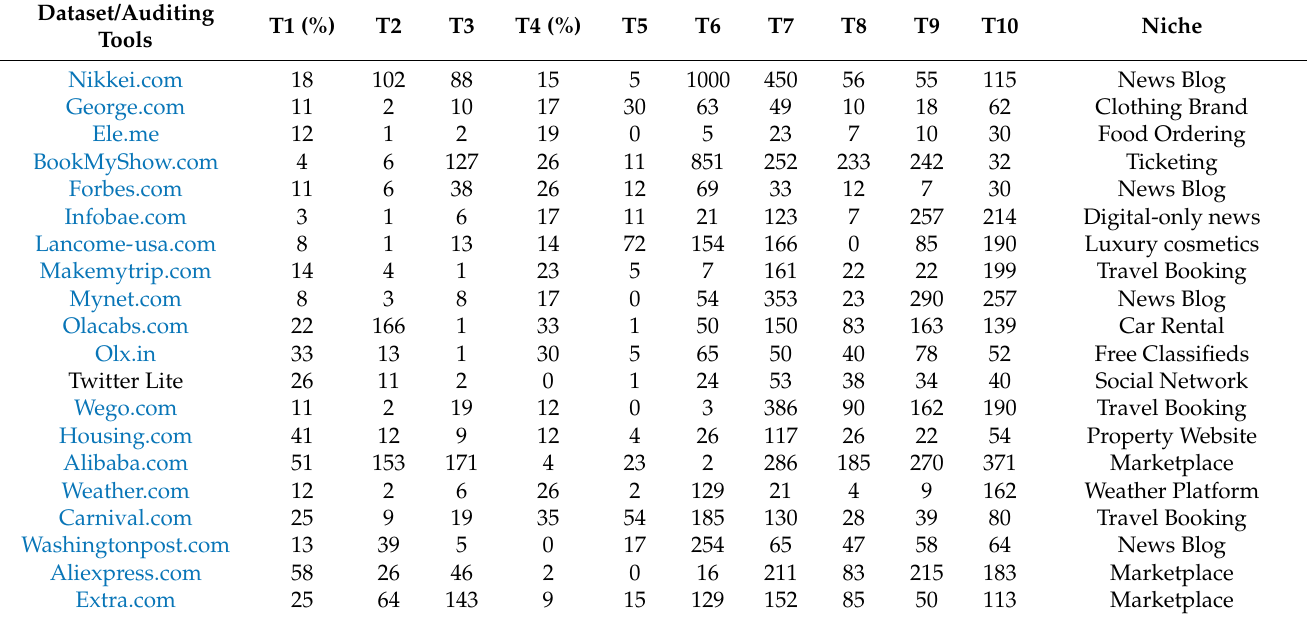
Table 3. Accessibility compliance errors for PWA websites.